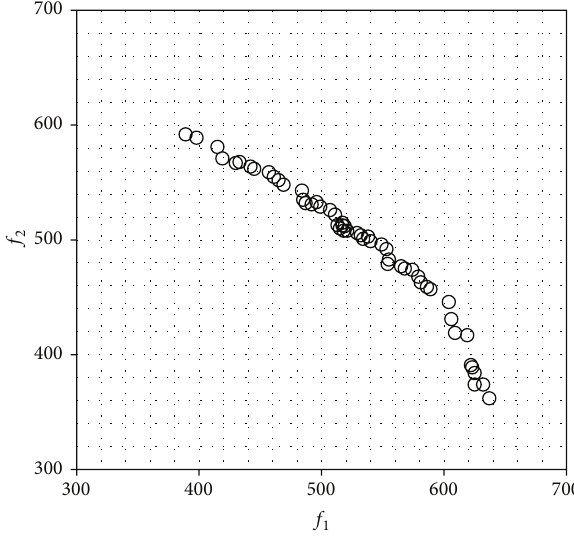
Figure 4: Nondominated solutions obtained by